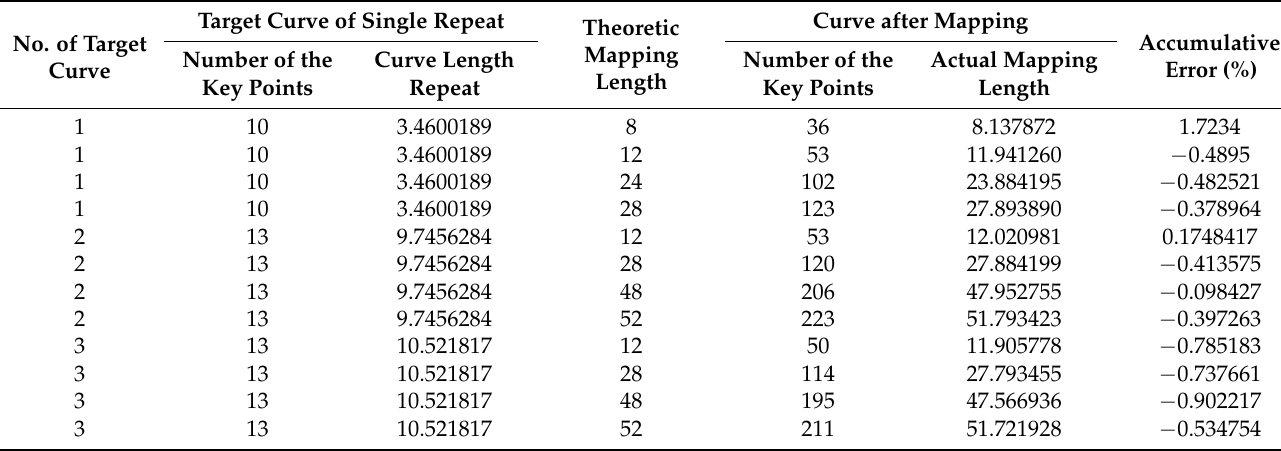
Table 3. The accumulative length errors at different mapping